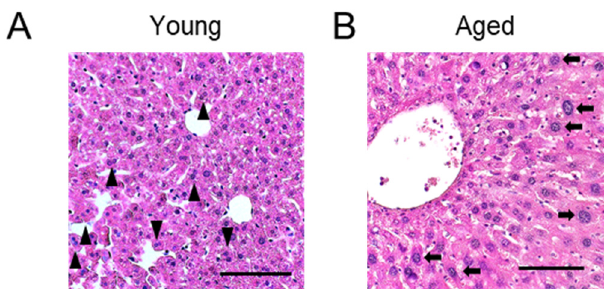
Figure 1. Histological images of livers in young ( A ) and aged ( B ) mice. Representative hematoxylin and eosin staining images are shown. ( A ) The liver of a 6-week-old mouse. Some binucleated polyploid hepatocytes are indicated by arrow heads. ( B ) The liver of a 69-week-old mouse. Polyploid hepatocytes with a large nucleus are indicated by arrows. Scale bars, 100 μ m.